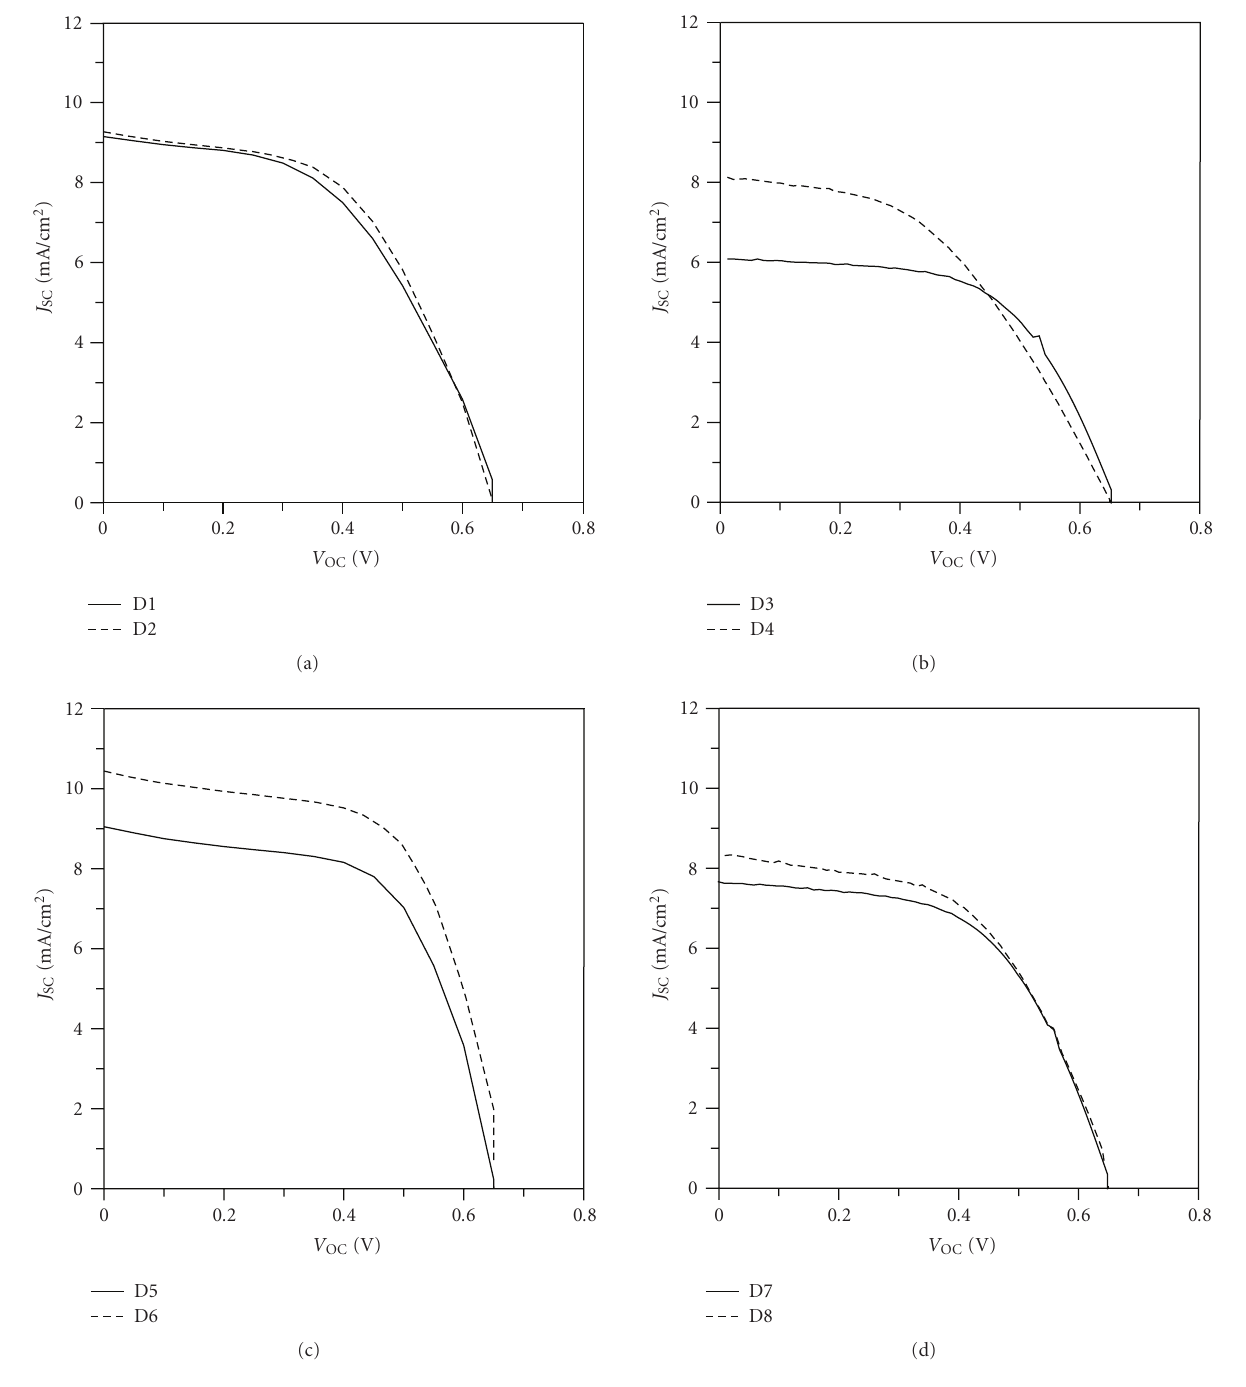
Figure 7: J - V characteristics in tests D1 to